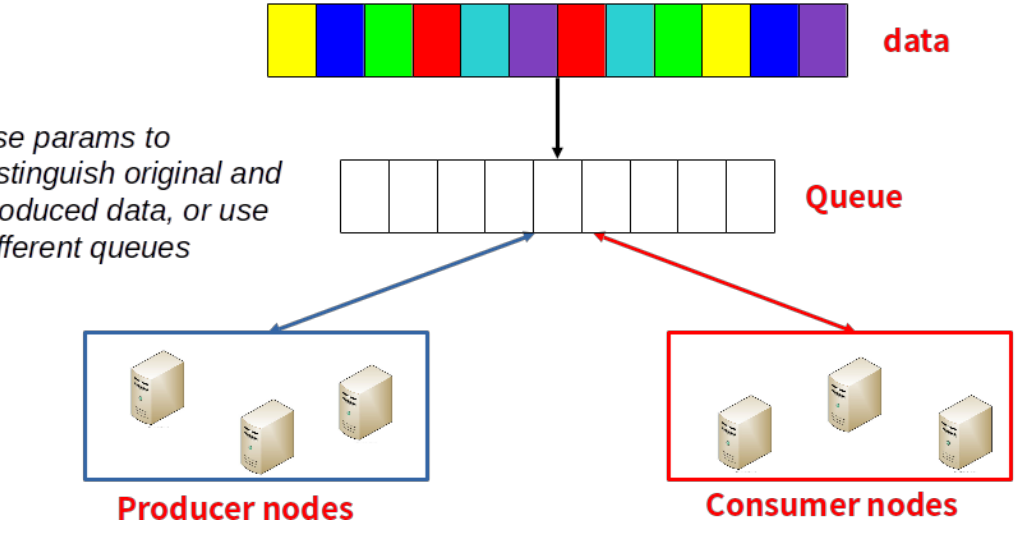
Figure 2. Producer